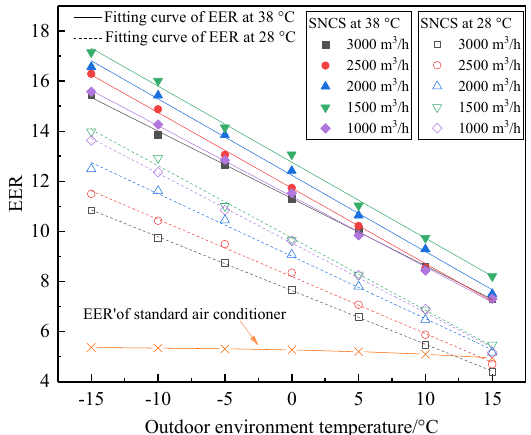
Figure 17. EER of two conditions under different q V , a and outdoor temperatures.